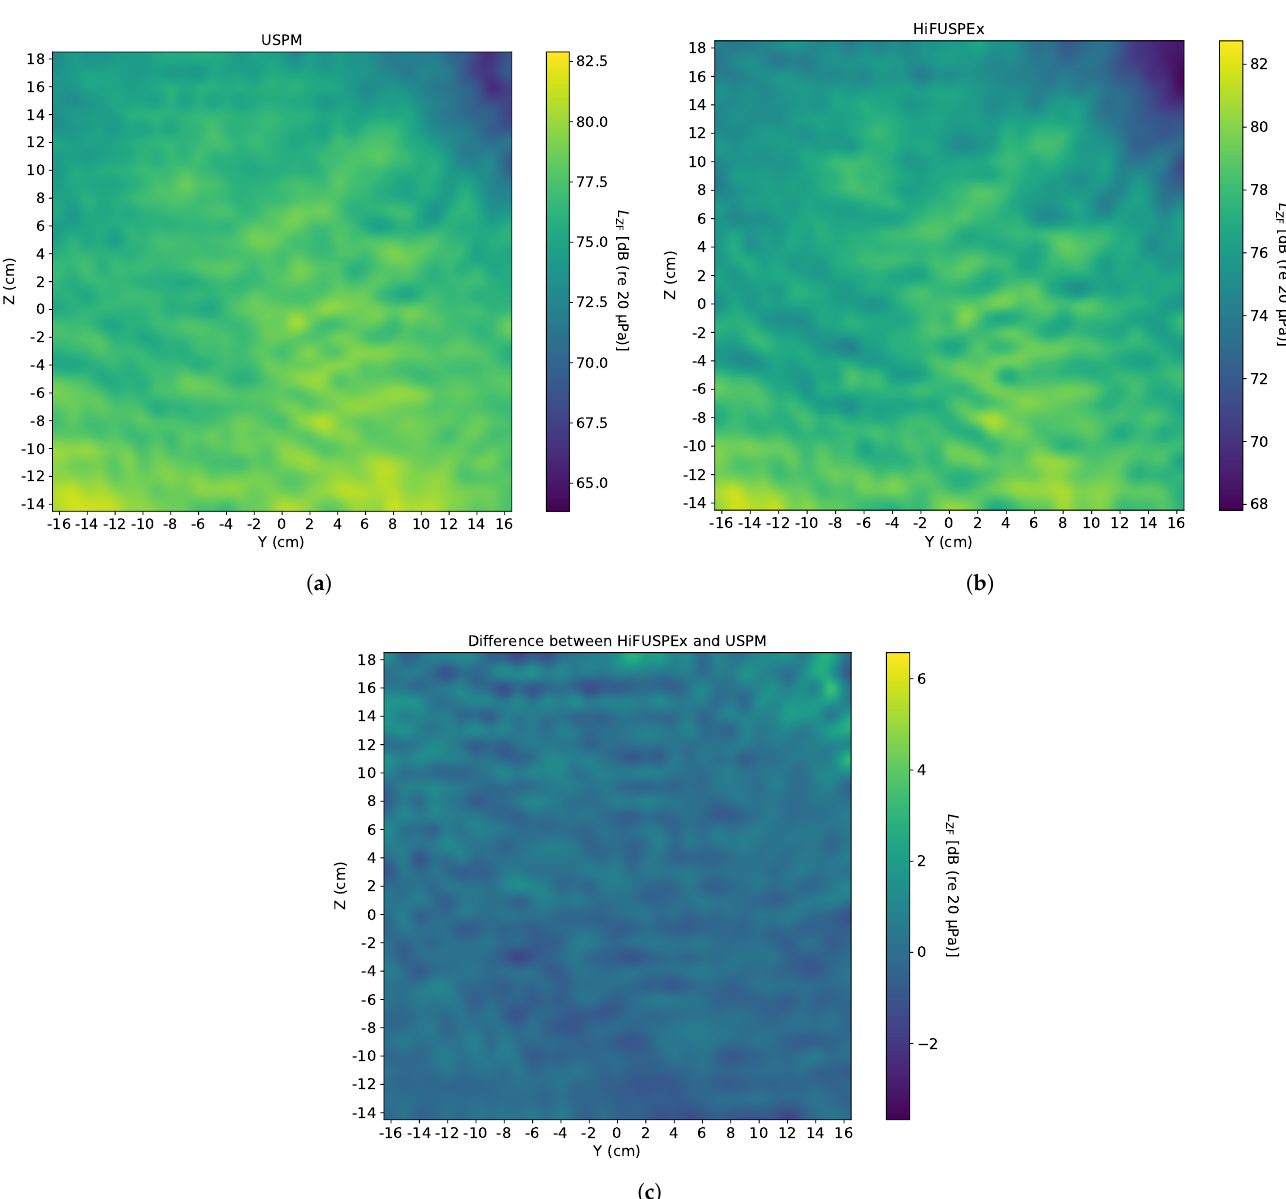
Figure 16. Sound fields within the scanning unit when an idealized signal of the ultrasonic cleaning bath was simulated. Results were obtained in the sedentary position, on the right-hand side, of the artificial head, without the protection grid. Presented plots show sound fields obtained for: ( a ) USPM, ( b ) HiFUSPEx, and ( c ) difference between the HiFUSPEx and the USPM. Please refer to Figure 10 for identification of zy